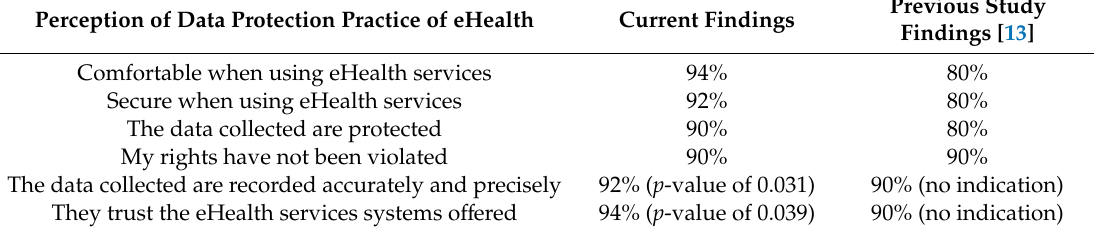
Table 5. Percent scores on the perception of data protection practice of eHealth providers in the current study in comparison to the previous study